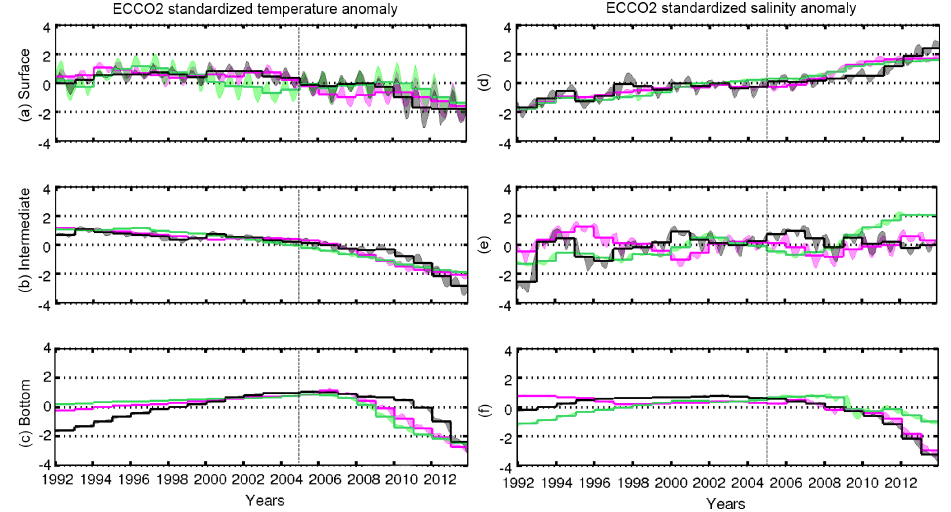
Figure 8. Time series of the ECCO2 temperature and salinity normalized anomalies for the Weddell Sea (green), Indian Ocean (magenta) and Western Pacific (black) sectors. The step plots represent the annual average of the anomalies, while the contours represent the monthly oscillations around the annual average. The dashed vertical line shows the opening of the Weddell Polynya, which stays open until the end of the